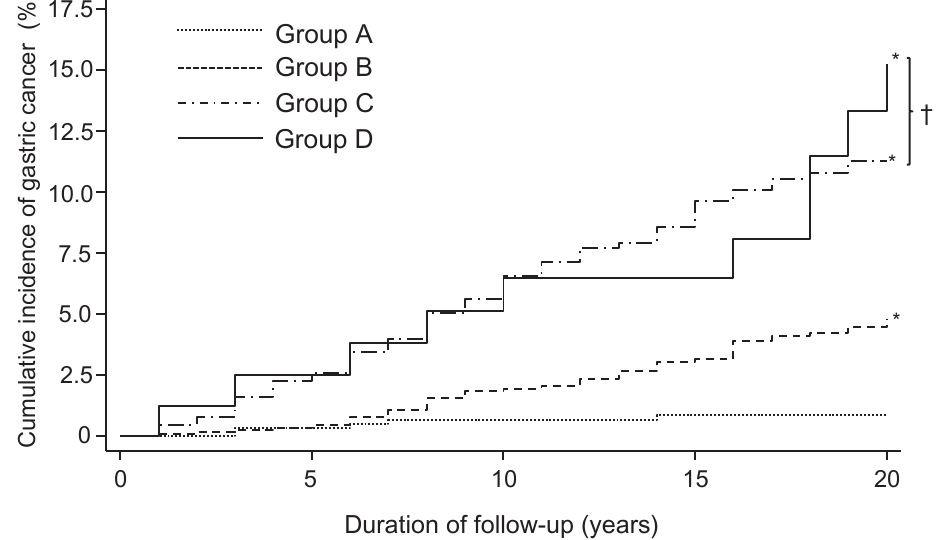
Figure. 20-year cumulative incidence of gastric cancer according to the combination of H. pylori antibody and serum pepsinogen at baseline. Groups A to D, see text for details. * P < 0.01 vs Group A, † P = 0.53 by log rank test.